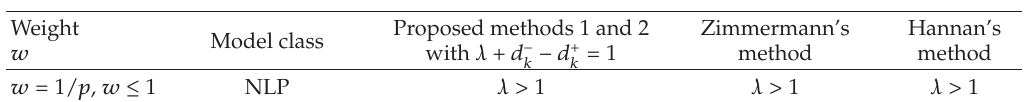
Table 3: Comparison.